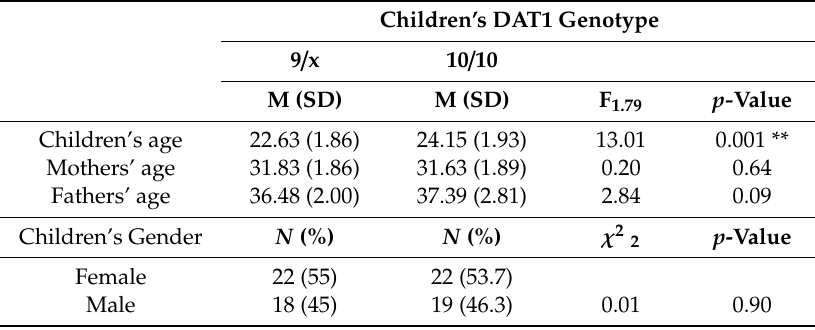
Table 1. Analysis of variance (ANOVA) and Chi-square analyses results.